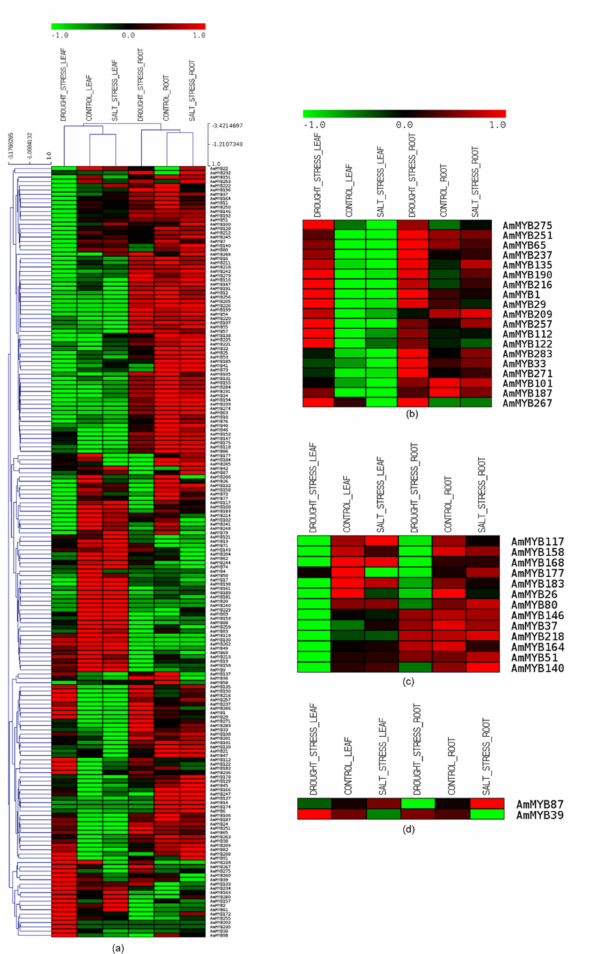
Figure 5. In silico differential expression of AmR2R3 MYB genes in response to abiotic stress. ( a ) Hierarchical clustering of the AmR2R3 MYB genes based on their expression in leaf and root tissue under salinity and drought stress. ( b ) AmR2R3 MYB genes upregulated in A. marina tissues in response to drought stress ( c ) AmR2R3 MYB genes downregulated in A. marina tissues in response to drought stress and ( d ) AmR2R3 MYB genes differentially regulated in response to salt stress in A. marina